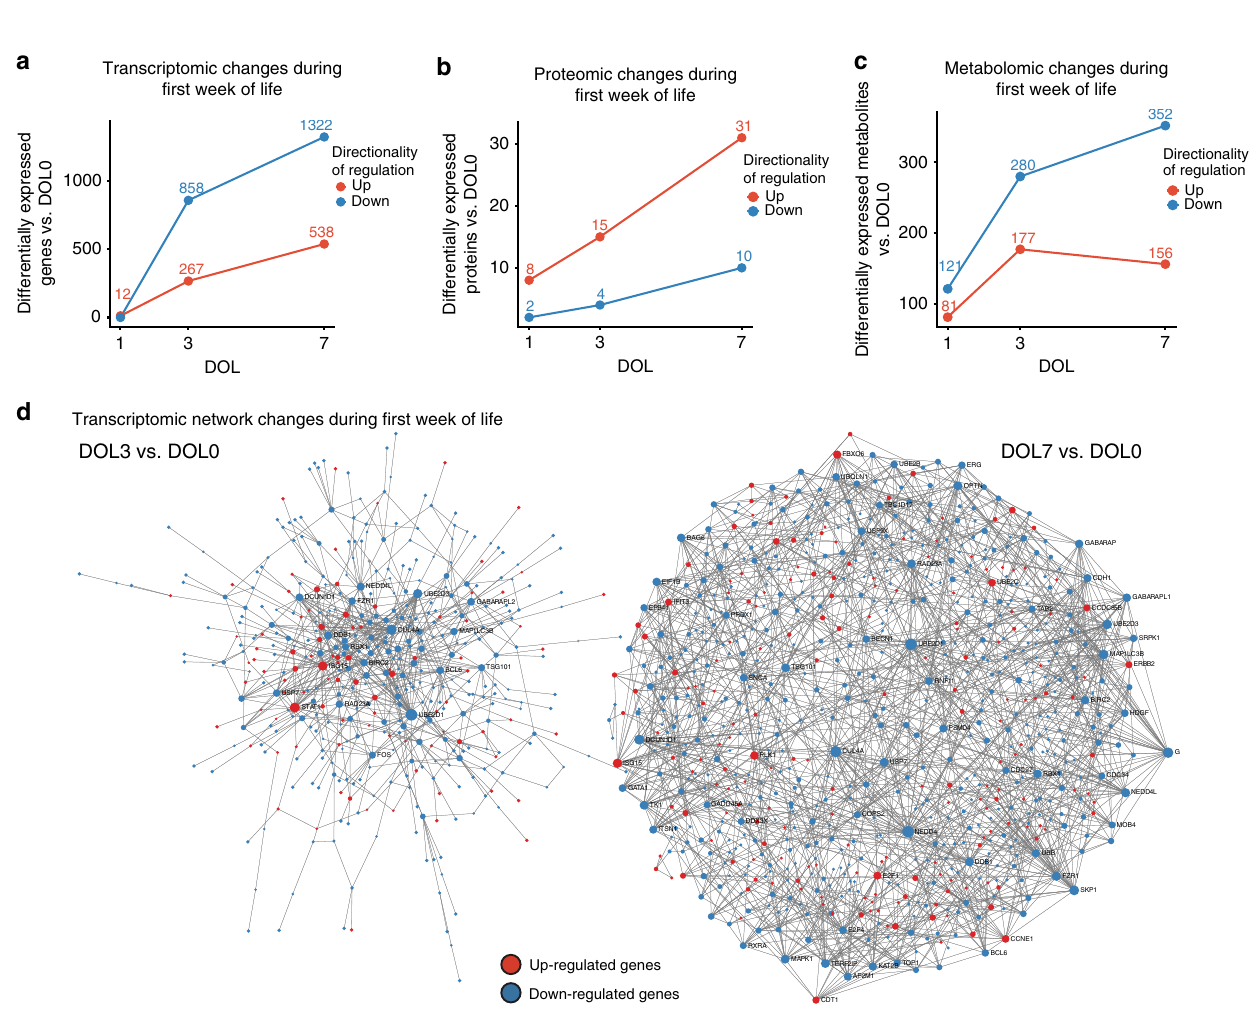
Fig. 3 Transcriptomic, proteomic, and metabolomic analyses identi fi ed a robust trajectory of differentially expressed genes, proteins, and metabolites over the fi rst week of life. a Up- and downregulated differentially expressed genes were plotted by DOL (vs. DOL0) and numbers of genes are listed above each point except for downregulated genes at DOL1 vs. DOL0, where the number was zero. b , c Up- and downregulated differentially expressed proteins and metabolites, respectively, plotted by DOL compared to DOL0, with numbers of differentially expressed proteins or metabolites listed above each point. d Zero-order interaction networks for genes differentially expressed at DOL3 vs. DOL0 and DOL7 vs. DOL0. Within networks, upregulated nodes are displayed in red and downregulated nodes in blue. DOL: day of life Data 8). For example, integrating transcriptomic with proteomic data af fi rmed the increase in type 1 IFN-related functions and the regulation of complement cascades over the fi rst week of life. This integration also revealed new biological insights not found in any single-data domain analysis, such as changes in cellular replica- tion machinery, creatine metabolism (DOL3), fi brin clotting cascade and signals of increasing adaptive immune and phago- some activity (DOL7).